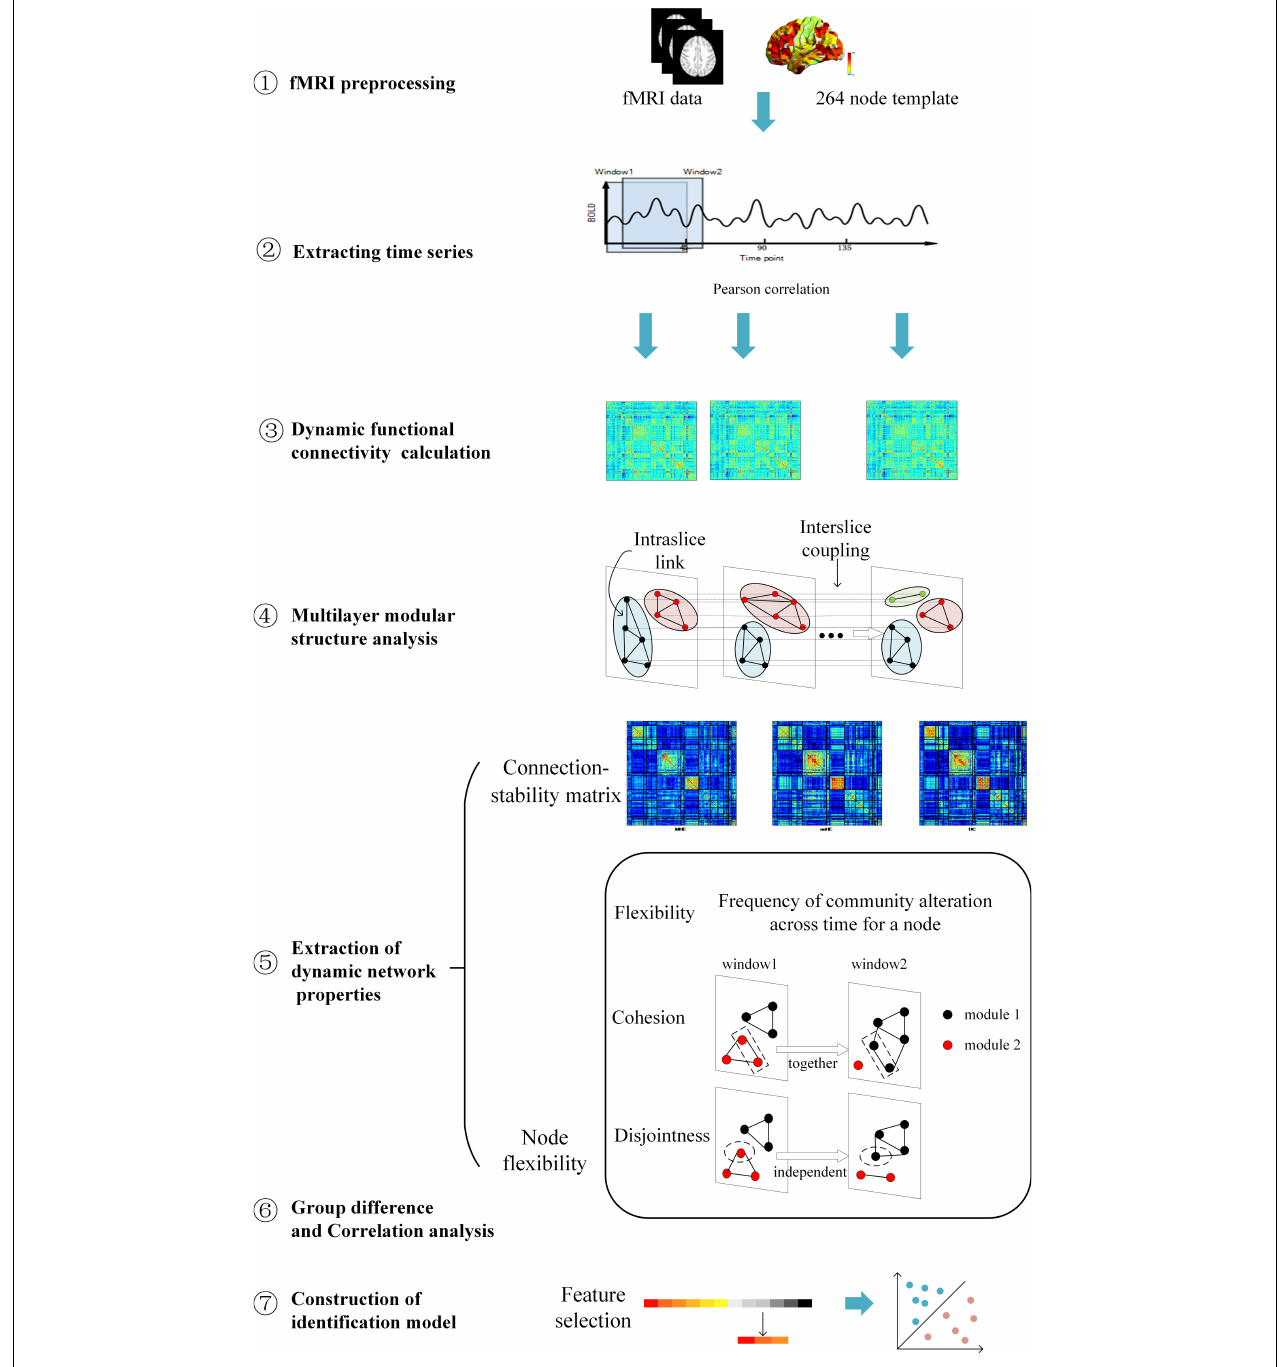
FIGURE 1 | An overview of data analysis pipeline. (cid:192) . fMRI data preprocessing; (cid:193) . Extracting regional time series based on Power’s 264 atlas; (cid:194) . Sliding-window based dynamic functional connectivity matrix calculation; (cid:195) . Multi-layer modular structure calculation from the dynamic brain connectivity matrix; (cid:196) . Extraction of dynamic network properties; (cid:197) . Group difference of dynamic network properties and their correlations with clinical cognitive test scores; (cid:198) . Construction of identification model based on dynamical network properties for individual MHE discrimination.